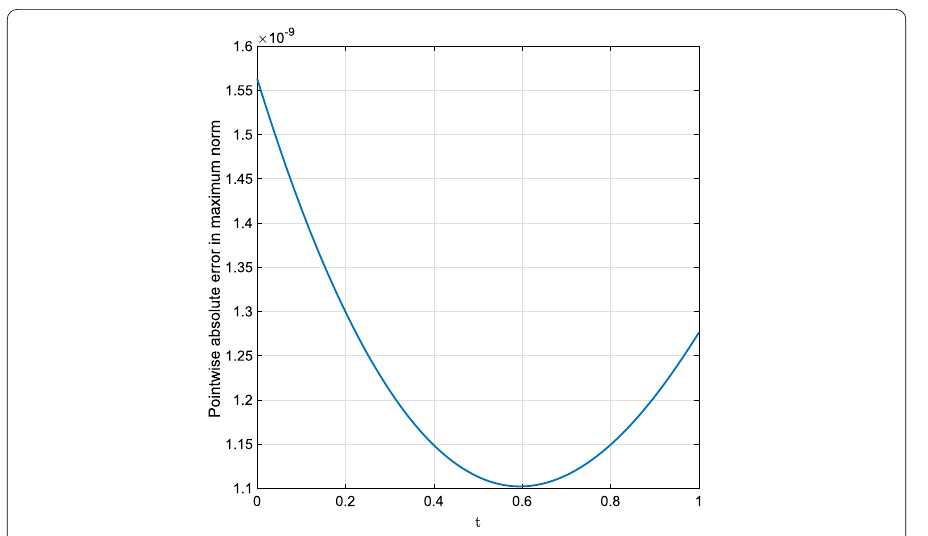
Figure 5 Pointwise absolute errors in maximum norm obtained by the proposed shooting technique with Halley’s method of Example 4.3 versus the time step h when ( α 1 , α 2 ) = (0.4,1.7), s 0 = 0.2, N = 320, m = 10